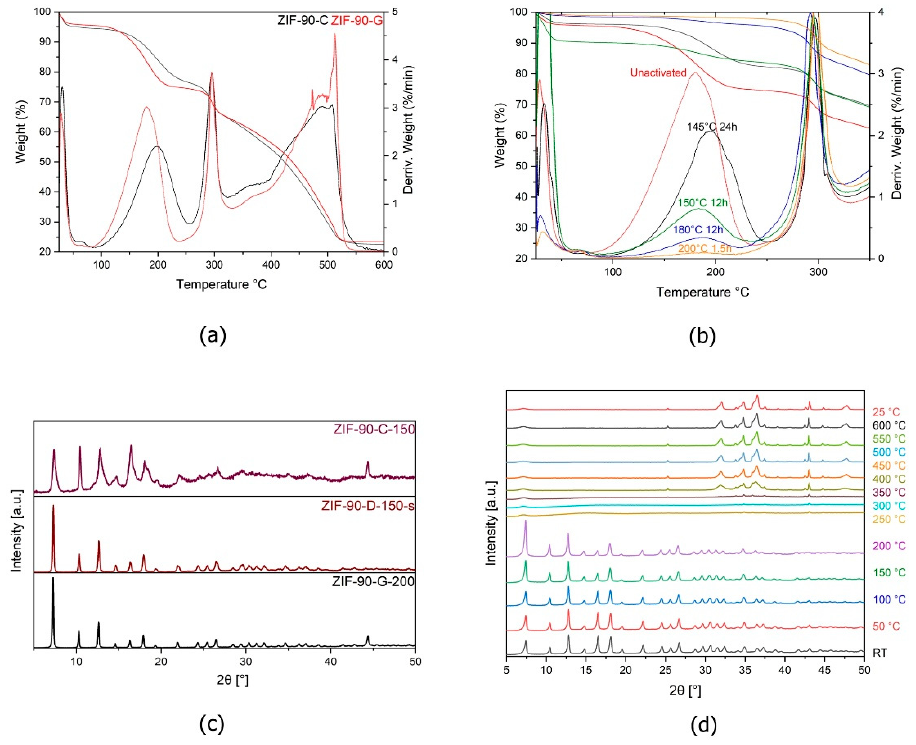
Figure 3. ( a ) TGA of ZIF-90-G and ZIF-90-C; ( b ) TGA of ZIF-90-G at different temperatures and times. For clarity, only the solvent peak region is shown; ( c ) PXRD of ZIF-90-C activated at 150, ZIF-90-D with classic solvent exchange activation and ZIF-90-G activated at 200 °C for 1.5 h; ( d ) High T PXRD for ZIF-90-G.